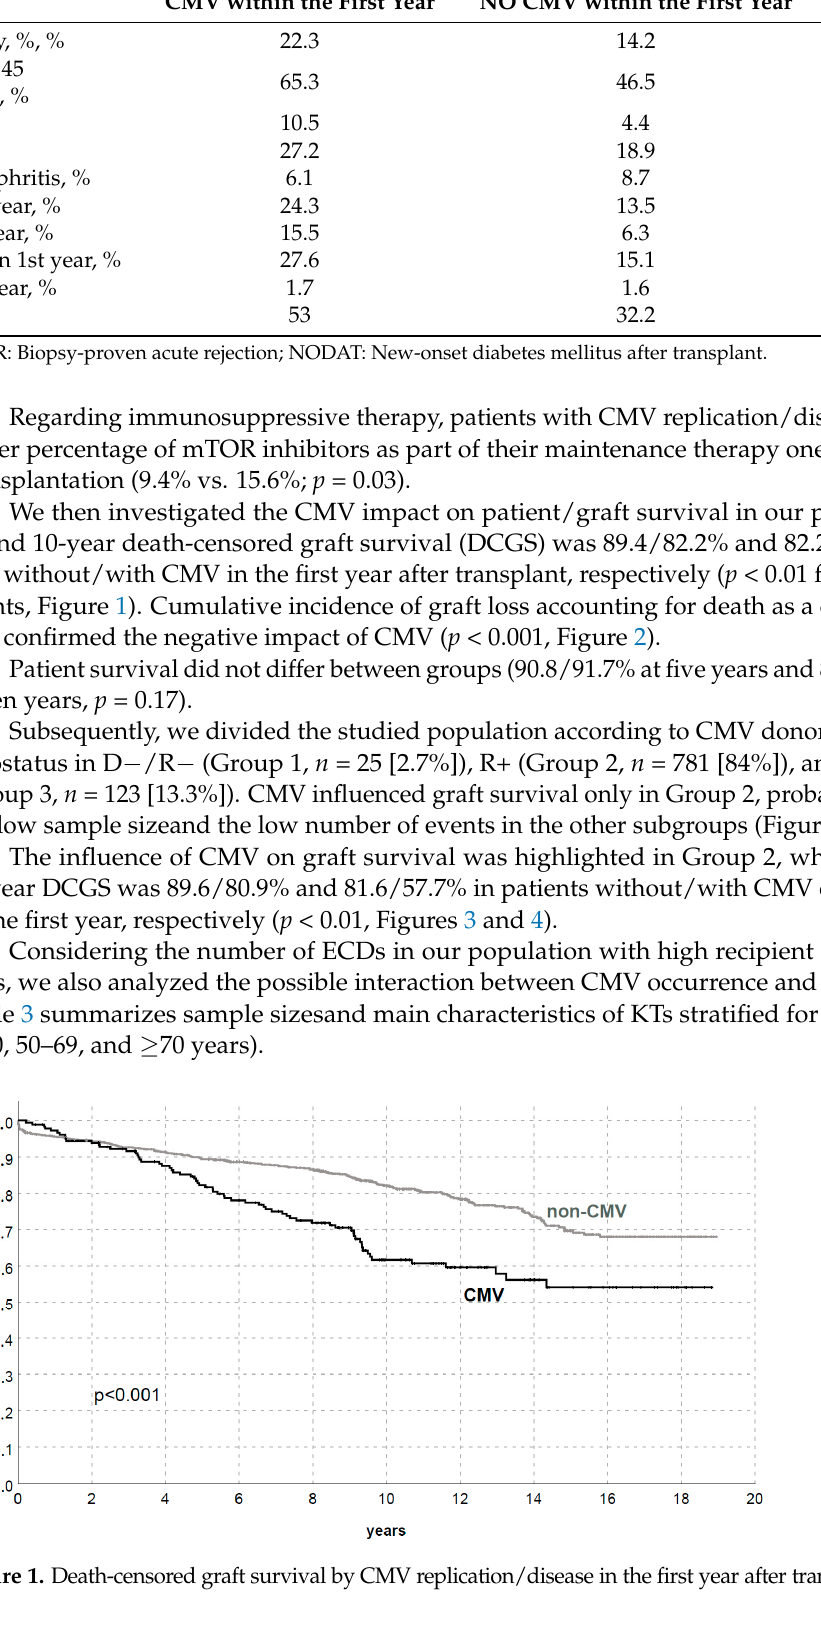
Figure 2. Cumulative incidence of graft loss, accounting for death as a competing risk, in patients with/without CMV replication/disease in the first year after transplantation. Patient survival did not differ between groups (90.8/91.7% at five years and 80.1/79.3% at ten years, p = 0.17). Subsequently, we divided the studied population according to CMV donor/recipient serostatus in D − /R − (Group 1, n = 25 [2.7%]), R+ (Group 2, n = 781 [84%]), and D+/R − (Group 3, n = 123 [13.3%]). CMV influenced graft survival only in Group 2, probably due to the low sample sizeand the low number of events in the other subgroups (Figures 3 and 4).